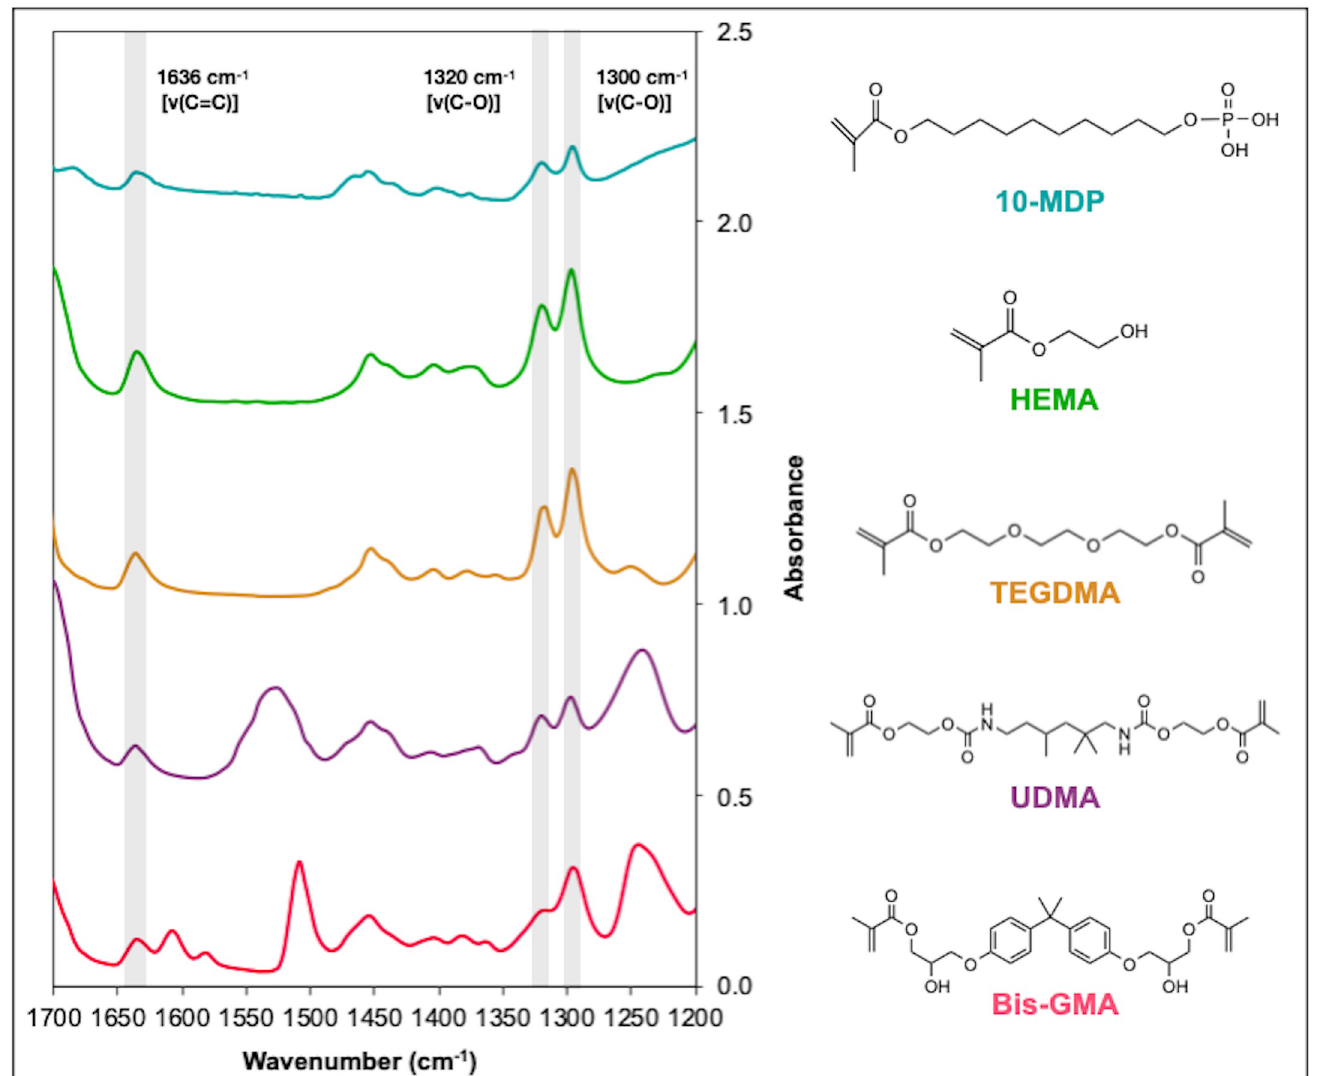
Fig 1. FTIR spectra and chemical structure of dimethacrylates Bis-GMA, UDMA, TEGDMA and monomethacrylates HEMA and 10-MDP. C-O stretch doublet can be seen at 1300 and 1320 cm -1 together with 1636 [v(C = C)] bond.